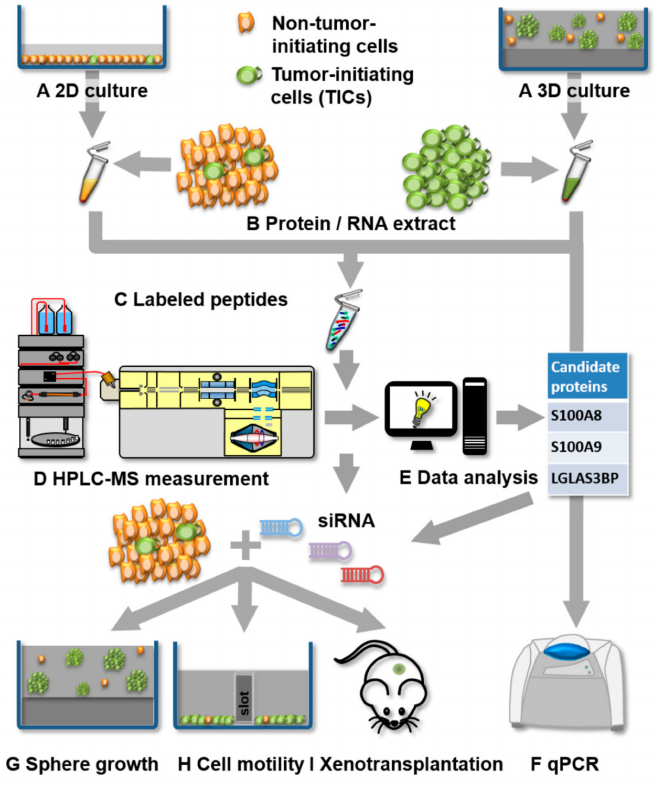
Figure 1. Workflow of di ff erential quantitative proteomics of pancreatic cancer stem cells (CSCs) and non-CSCs followed by gene expression analysis and biological validation of selected target genes: Sample preparation involves cell culture ( A ), protein / RNA extraction ( B ), and protein digestion and labeling ( C ). Measurement of di ff erential protein expression is performed by HPLC-MS / MS ( D ) and statistical analysis ( E ): Di ff erentially expressed candidate proteins are verified at the transcript level by qPCR ( F ). Finally, candidate proteins / genes are validated using functional assays such a sphere growth ( G ), cell motility ( H ), or tumor initiation and growth in xenotransplants ( I ) upon siRNA-mediated